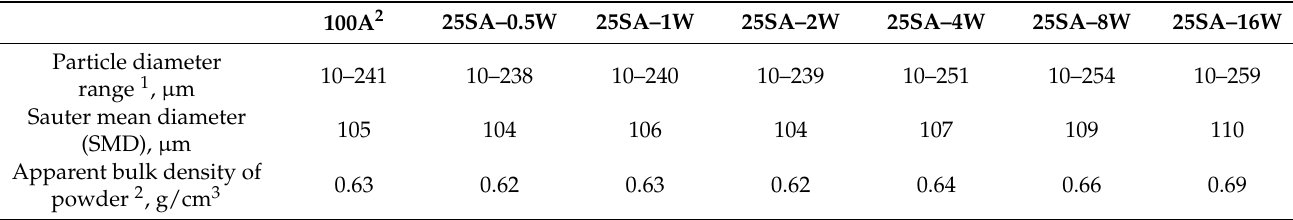
Table 3. Physical properties of the 25SA-WO x microspheres prepared from the microspheres obtained in the P2-DAR experiment (6000 rpm) and calcined at 550 ◦ C.